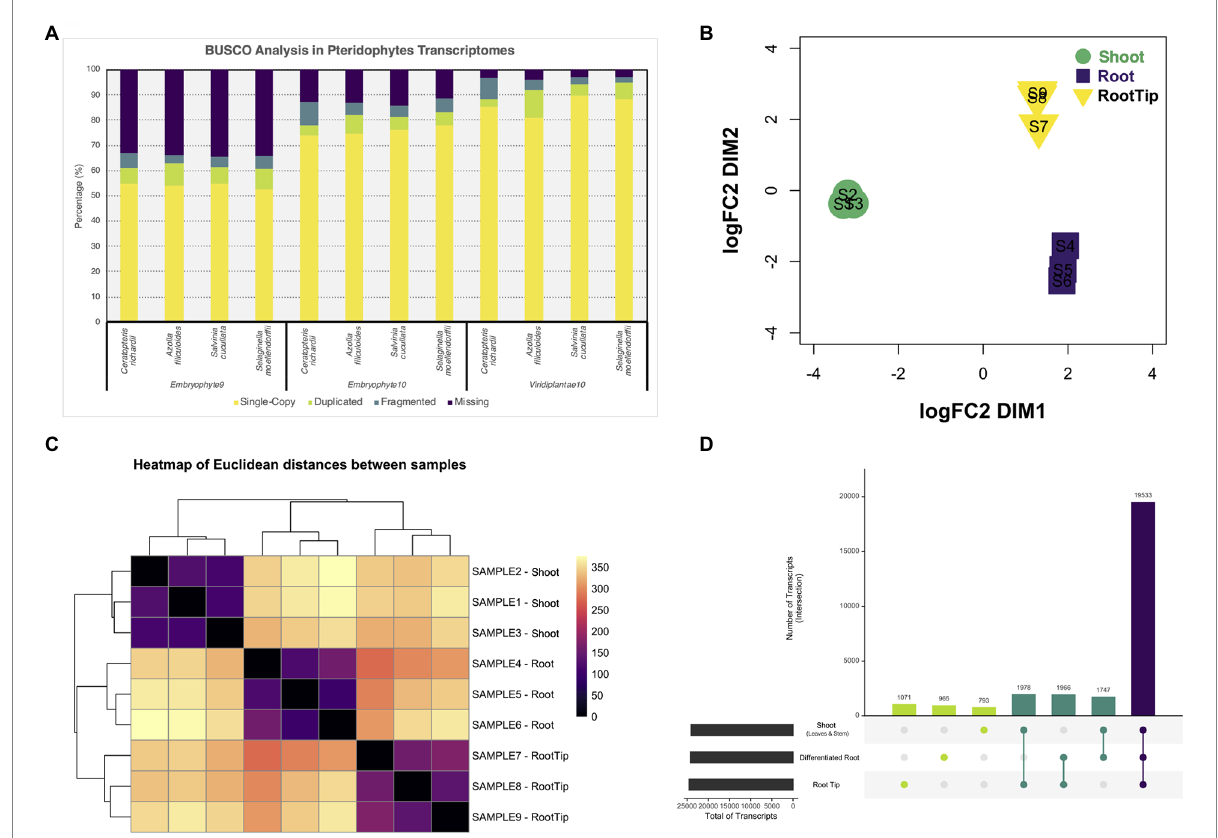
FIGURE 1 Differential gene expression analysis from tissues of Ceratopteris richardii young sporophyte. (A) Comparison of the gene content between pteridophytes transcriptomes using different BUSCO databases. (B) Multidimensional scaling analysis to examine how the different samples and segments are grouped between one another. (C) Heatmap showing the grouping between samples and segments. (D) Plot showing the unique and shared transcripts between plant